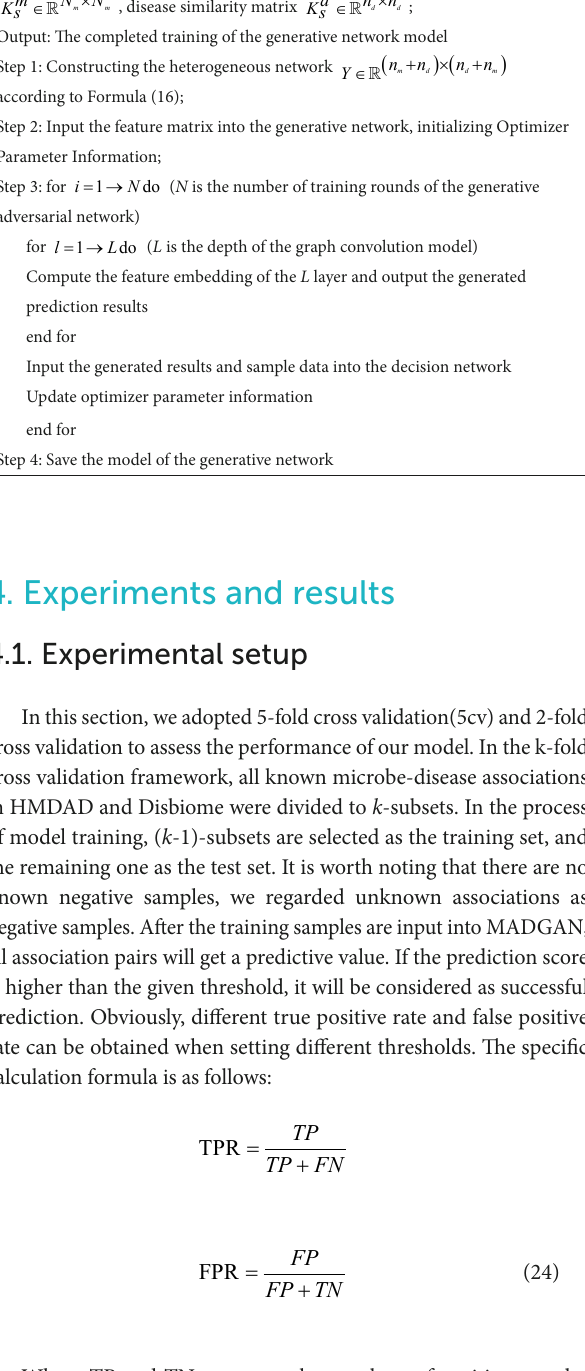
Algorithm 1: Algorithm of our proposed method Inputs: Known associations matrix